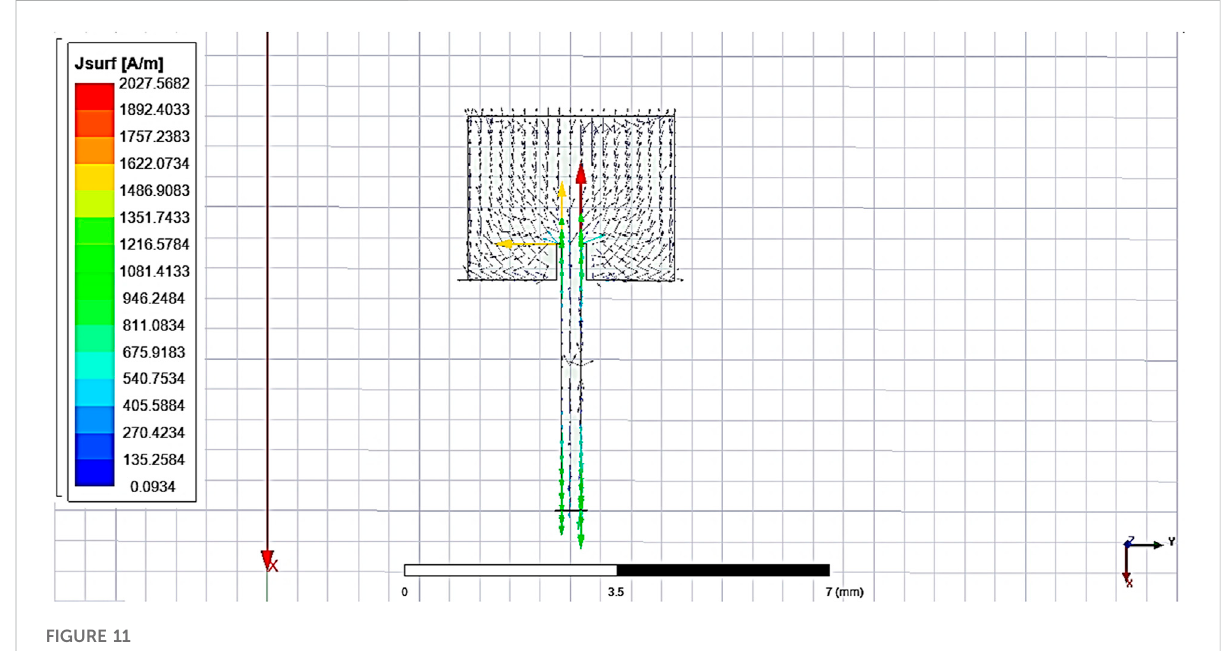
FIGURE 11 The surface current density distribution of the antenna at the resonance frequency.